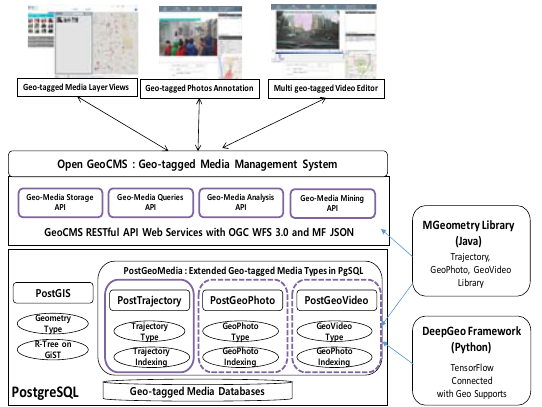
Figure 1. System architecture of Open